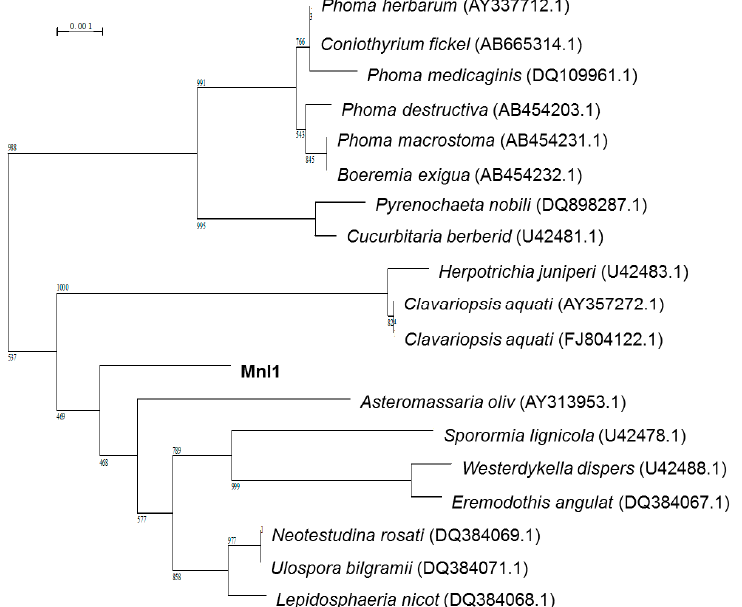
Figure 8. Phylogenetic tree showing the relationship of the fungal isolate MnI1 to other microorganisms based on 18S rRNA sequence homology (values in brackets are NCBI accession numbers). Scale bar is number of nucleotides substituted per base pair. Bootstrap values are given at the respective nodes. The tree was rooted with the 18S rRNA gene sequence of Saccharomyces cerevisiae (J01353.1). Oxidation of Mn (II) by isolate MnI1 was tested in liquid media at initial pH 6.5